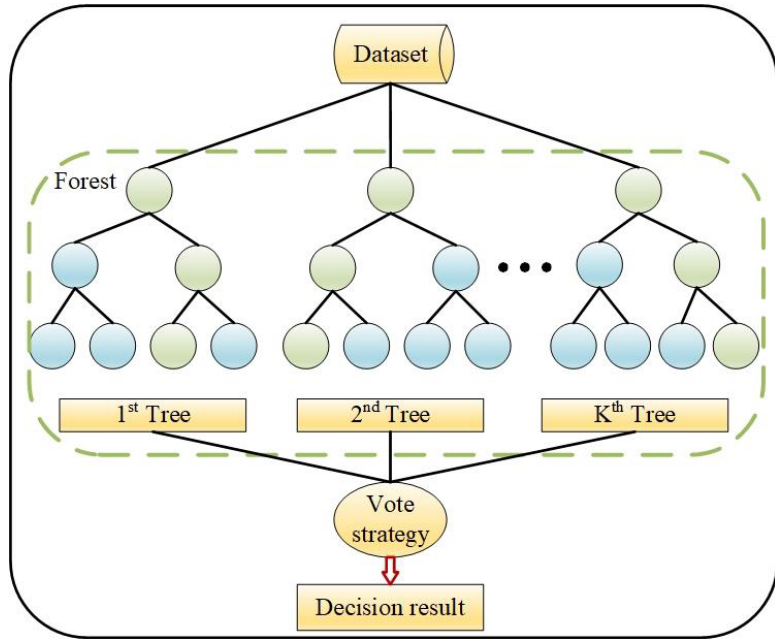
Figure 5. Diagram showing the principles of the random forest method. Table 1. Confusion matrix of the classification